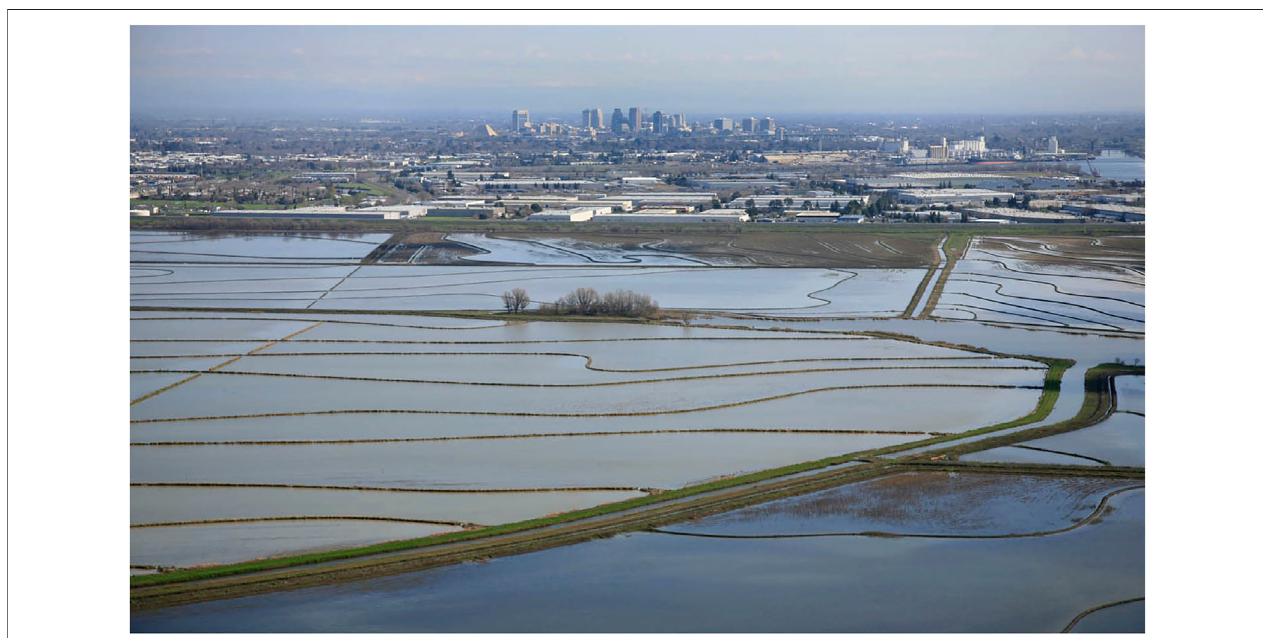
FIGURE 4 | Yolo Bypass fl oodplain and view of downtown Sacramento, 2007 (courtesy of California Department of Water Resources).